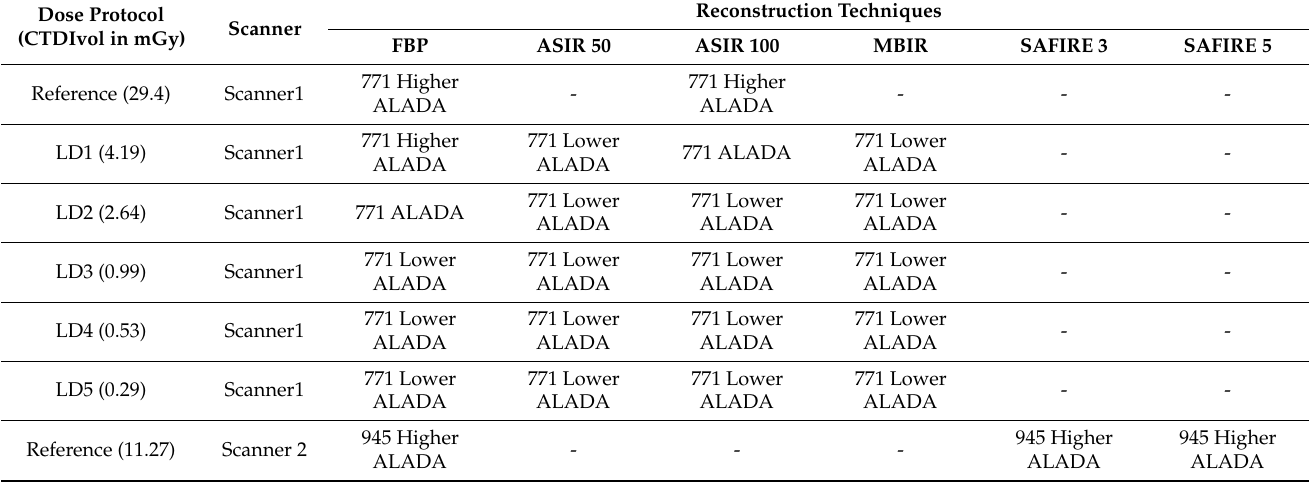
Table 1. Total number of image sections and their ALADA designation (ALADA dose, or higher or lower than the ALADA dose) according to the MDCT scanner, reconstruction technique, and dose. CTDIvol: volume CT dose index; LD: low dose protocol; mGy: milli Grays; FBP: filtered backprojection; ASIR: adaptive statistical iterative reconstruction; MBIR: model based iterative reconstruction; SAFIR: sinogram-affirmed iterative